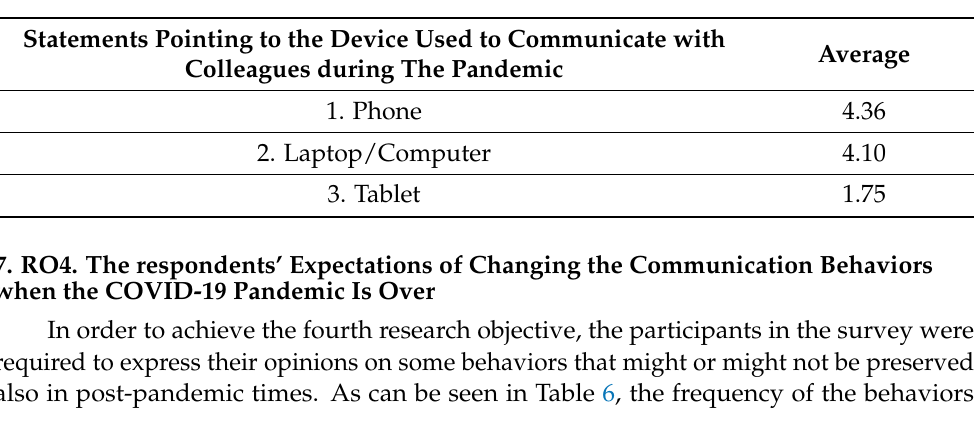
Table 5. Statements pointing to the device used to communicate with colleagues during the